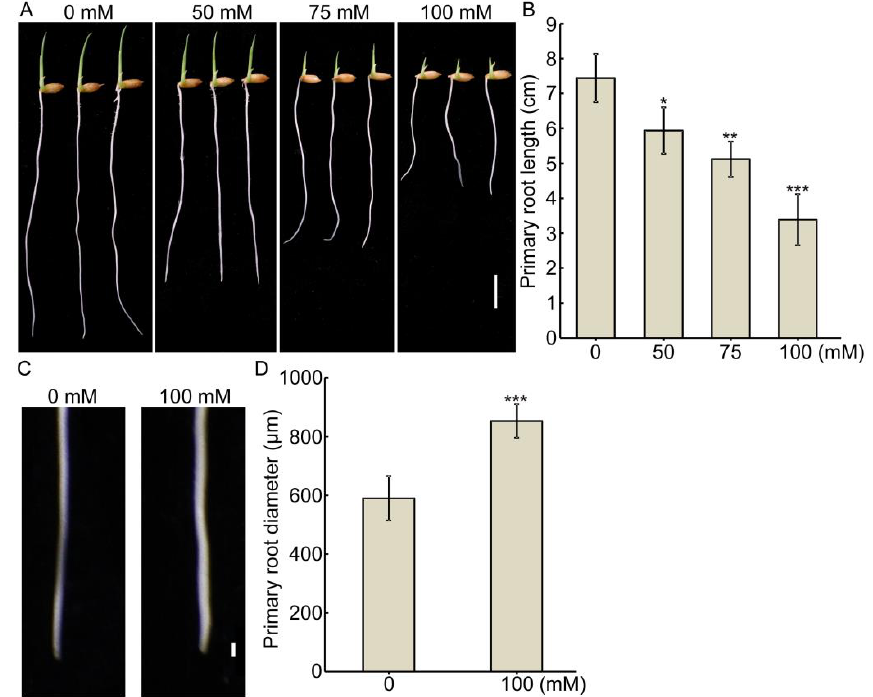
Figure 1. Salt stress inhibits root elongation and promotes root swelling. ( A , C ) Root phenotypes of (Nipponbare) Nip seedlings with various concentrations of NaCl treatment. Rice seedlings were grown under normal conditions for 4 days in the various concentrations of NaCl aqueous solution. Bar = 1 cm ( A ) or 1 mm ( C ). ( B , D ) Primary root length ( B ) and primary root diameter ( D ) of the seedlings shown in ( A , C ). Each column is the average of 30 seedlings and the bars indicate ± SD. The asterisks indicate significant differences compared to 0 mM NaCl (* p < 0.05, ** p < 0.01, *** p < 0.001, Student’s t -test).